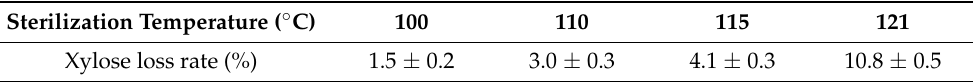
Table 4. Effect of different sterilization temperatures on the xylose loss rate of hydrolysate. Sterilization Temperature ( ◦